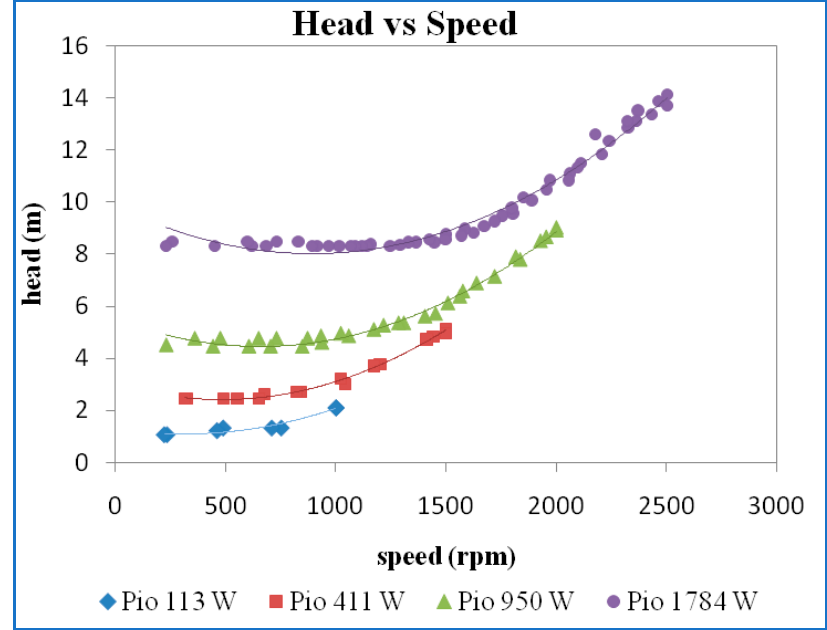
Figure 16. Head vs. speed at a guide vane opening of 16 mm.